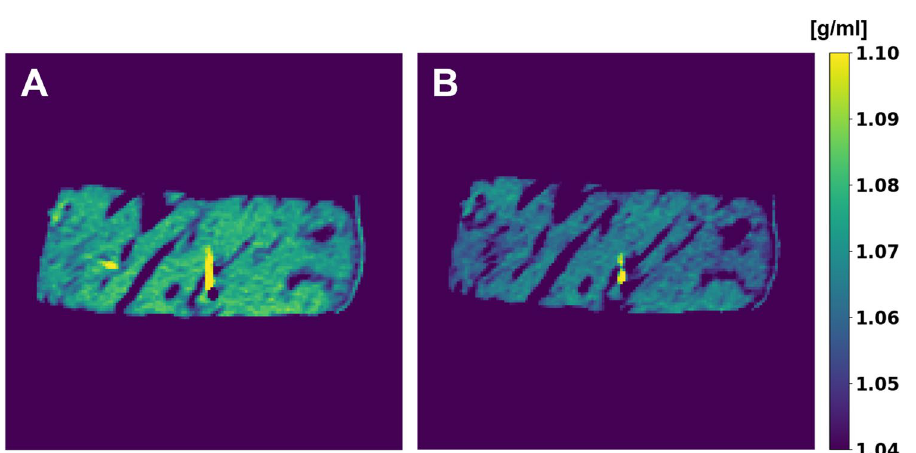
Figure 6. Physical density maps of ex vivo bovine muscle in water (ρ = 1 g/cm 3 ) at the lowest (22 °C, A ) and highest (45.5 °C, B ) temperatures. Increase in temperature resulted in a decrease in physical density. The area of high constant physical density (yellow) corresponds to optical fiber temperature probes placed to obtain ground truth temperature